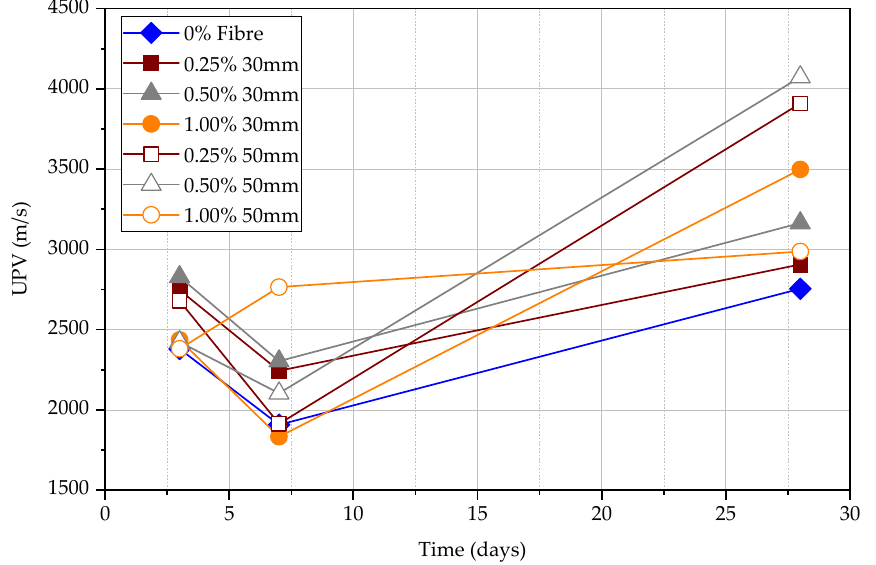
Figure 18. UPV indirect measurements with 100 mm path length.